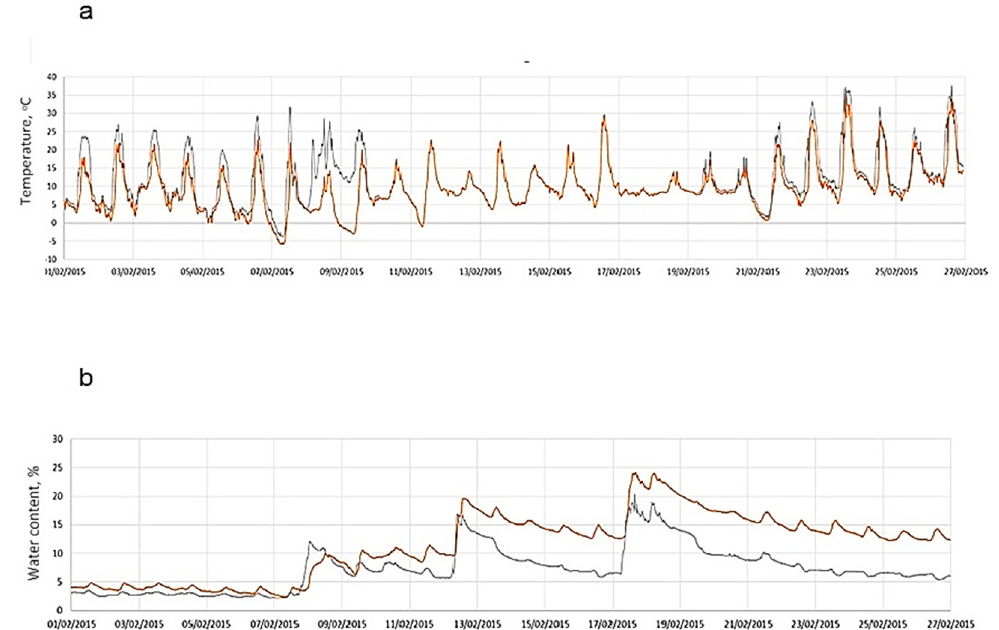
Figure 2. ( a ) Surface temperature and ( b ) water content in subcrust soil layer measured during February 2015 at cyanobacterial crusts (black line) and crusts dominated by Diploschistis diacapsis (carrot line) at a north-oriented position at the Tabernas Desert .